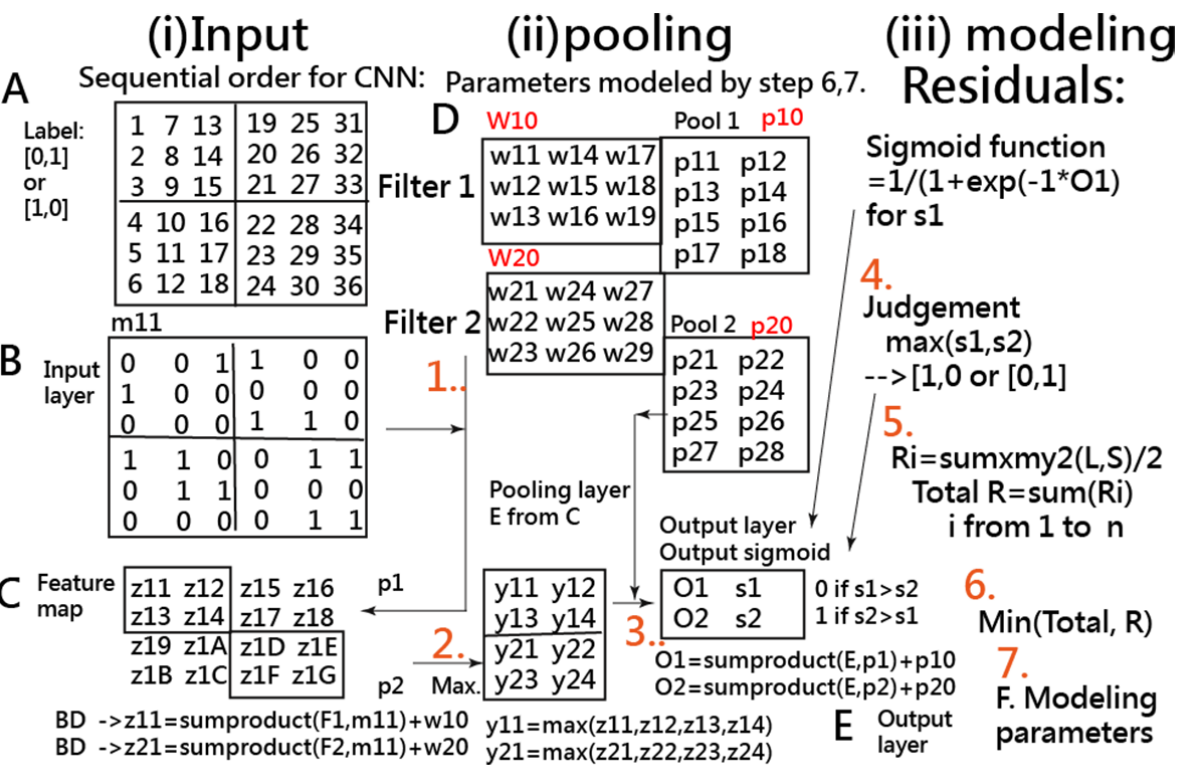
Figure 1. Interpretation of the convolutional neural network algorithm.